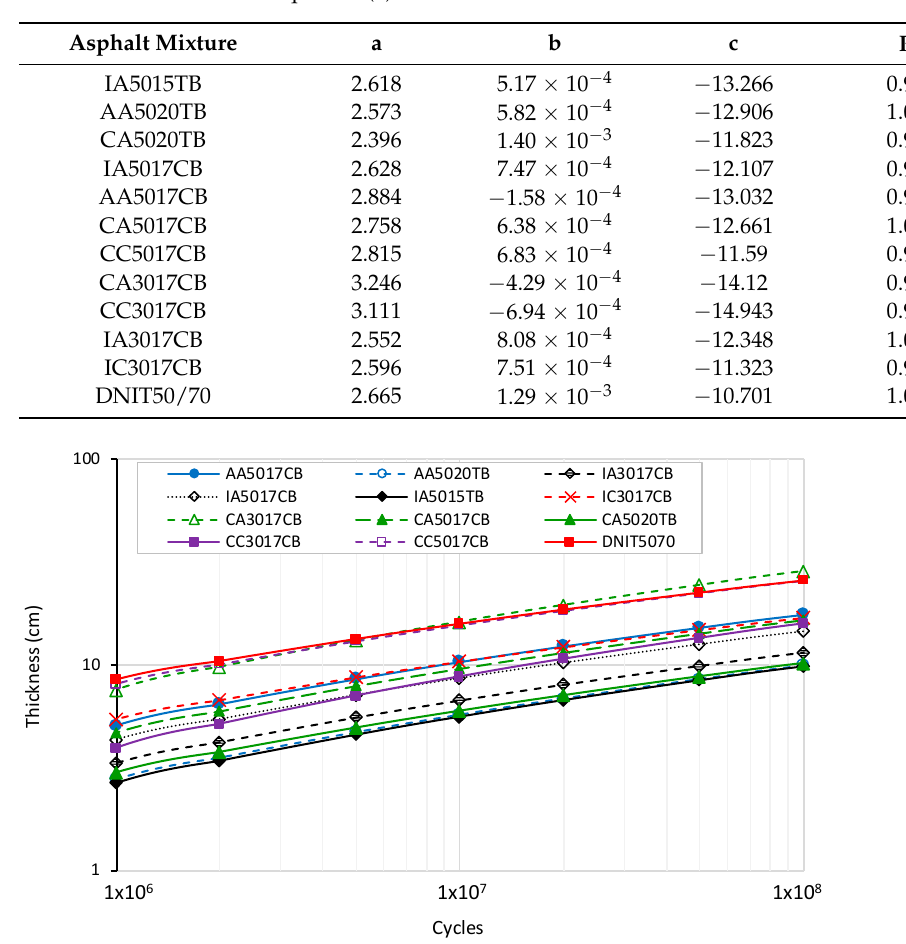
Table 11. Coefficients for Equation (4).